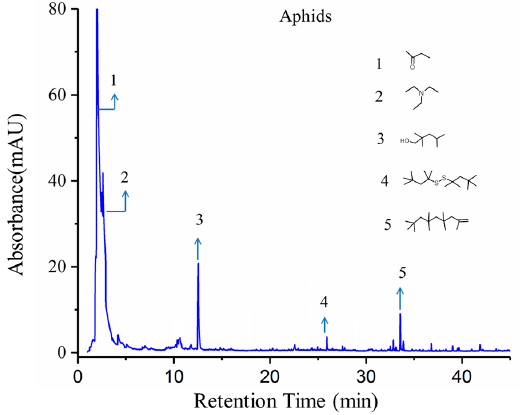
Figure 10. The GC-MS spectra of the VOCs of aphids.